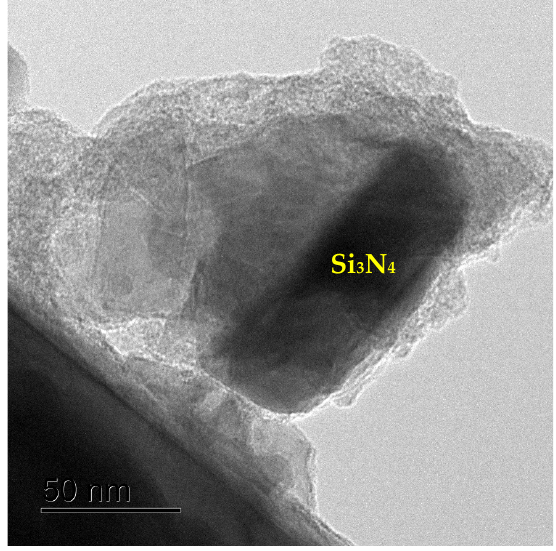
Figure 2. TEM image of the I ‐ 8.5 powder mixture.